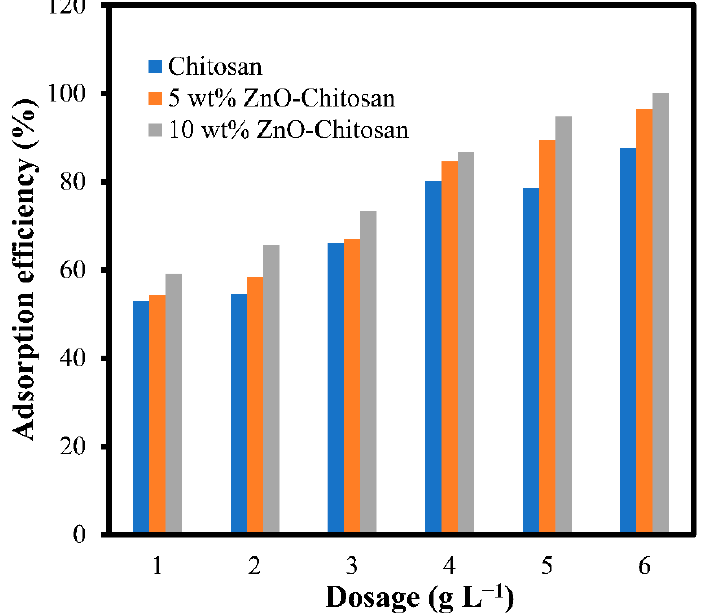
Figure 5. Effects of adsorbent dosage for the dye adsorption onto the chitosan and the nanocomposite.